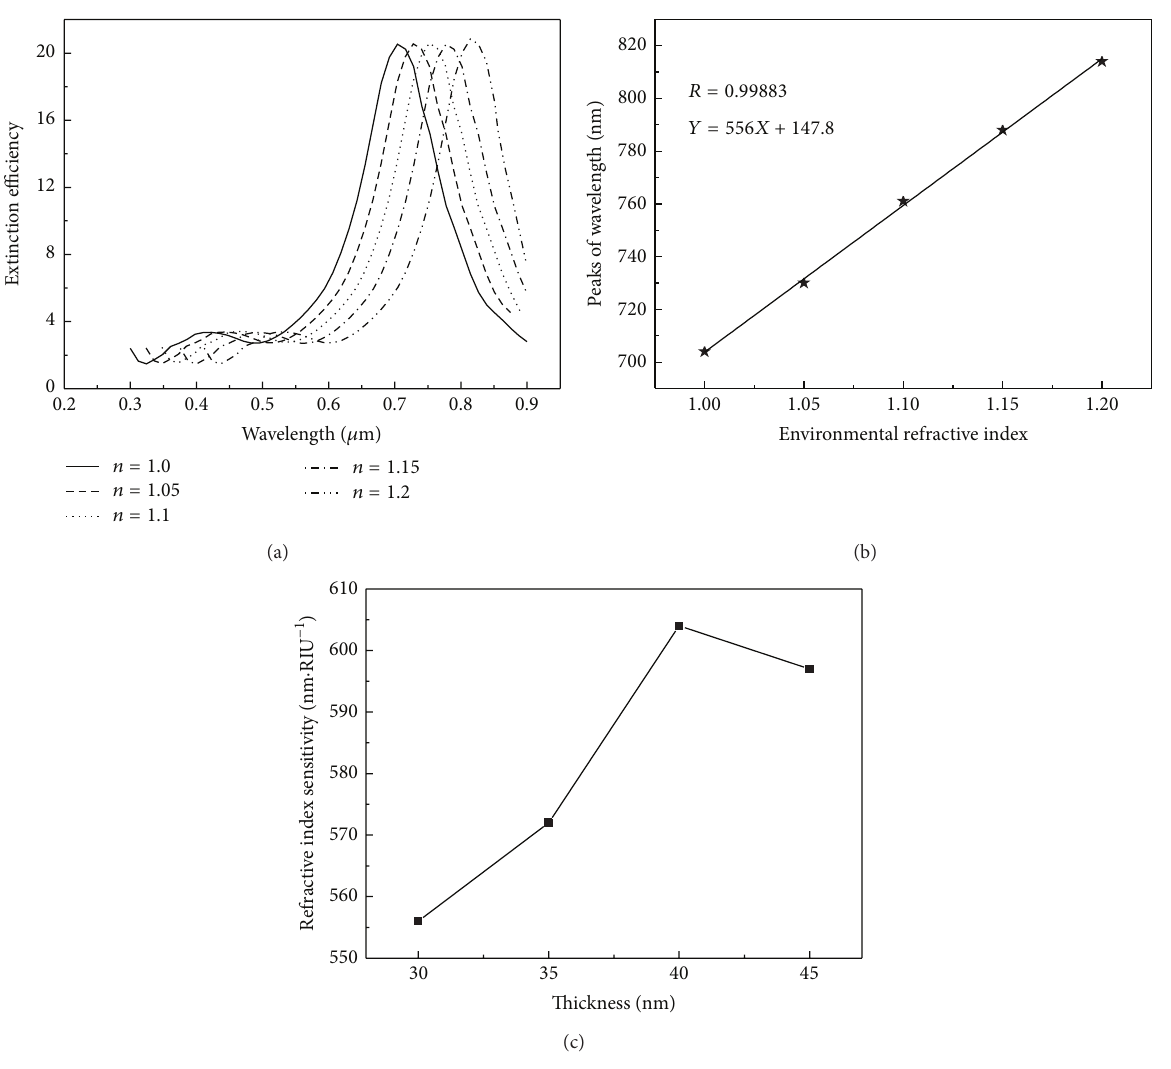
Figure 3: (a) Extinction spectra in different media for 30 nm Ag layer thickness. (b) Refractive index sensitivity curve for 30 nm Ag layer thickness. (c) Refractive index sensitivity distributions for different Ag layer